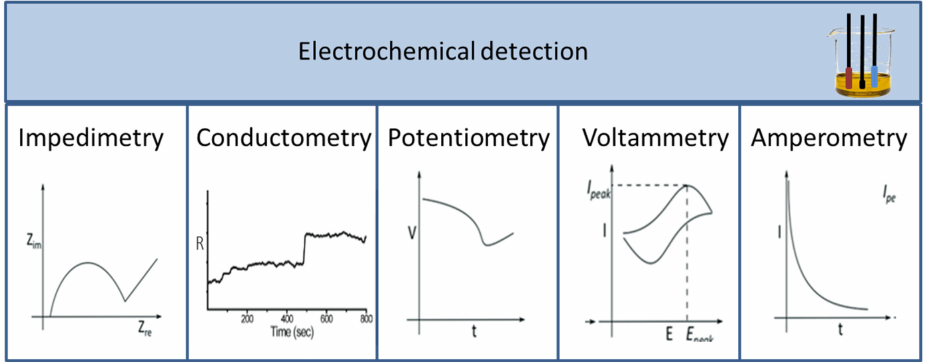
Figure 3. Different types of electrochemical sensors and their characteristic